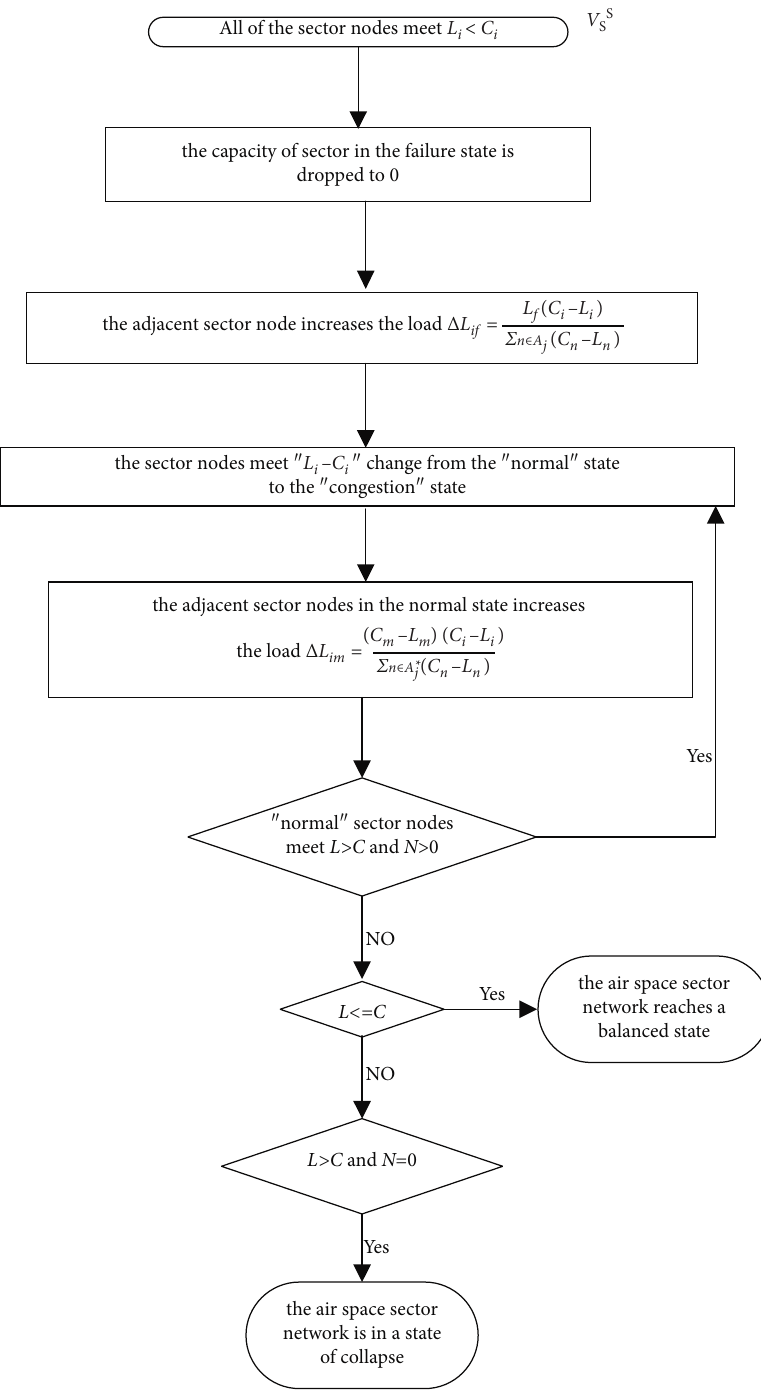
Figure 3: The flowchart of the adjacent load redistribution strategy based on the nodes’ remaining